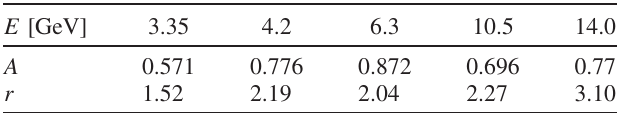
TABLE III. A table of the fitting parameters used to describe the distribution in the “ amorphous ”